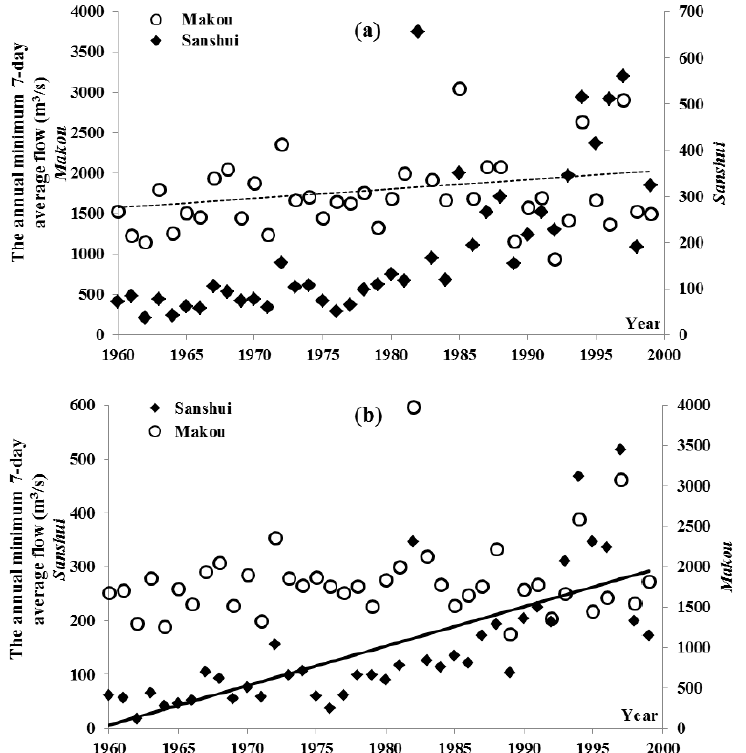
Figure 3. The annual minimum seven-day low flow as a function of time and the corresponding linear at ( a ) Makou (dashedline) and ( b ) Sanshui station (solid line). Their simultaneously flows at Sanshui in ( a ) oratMakou in ( b ) are also presented, respectively.